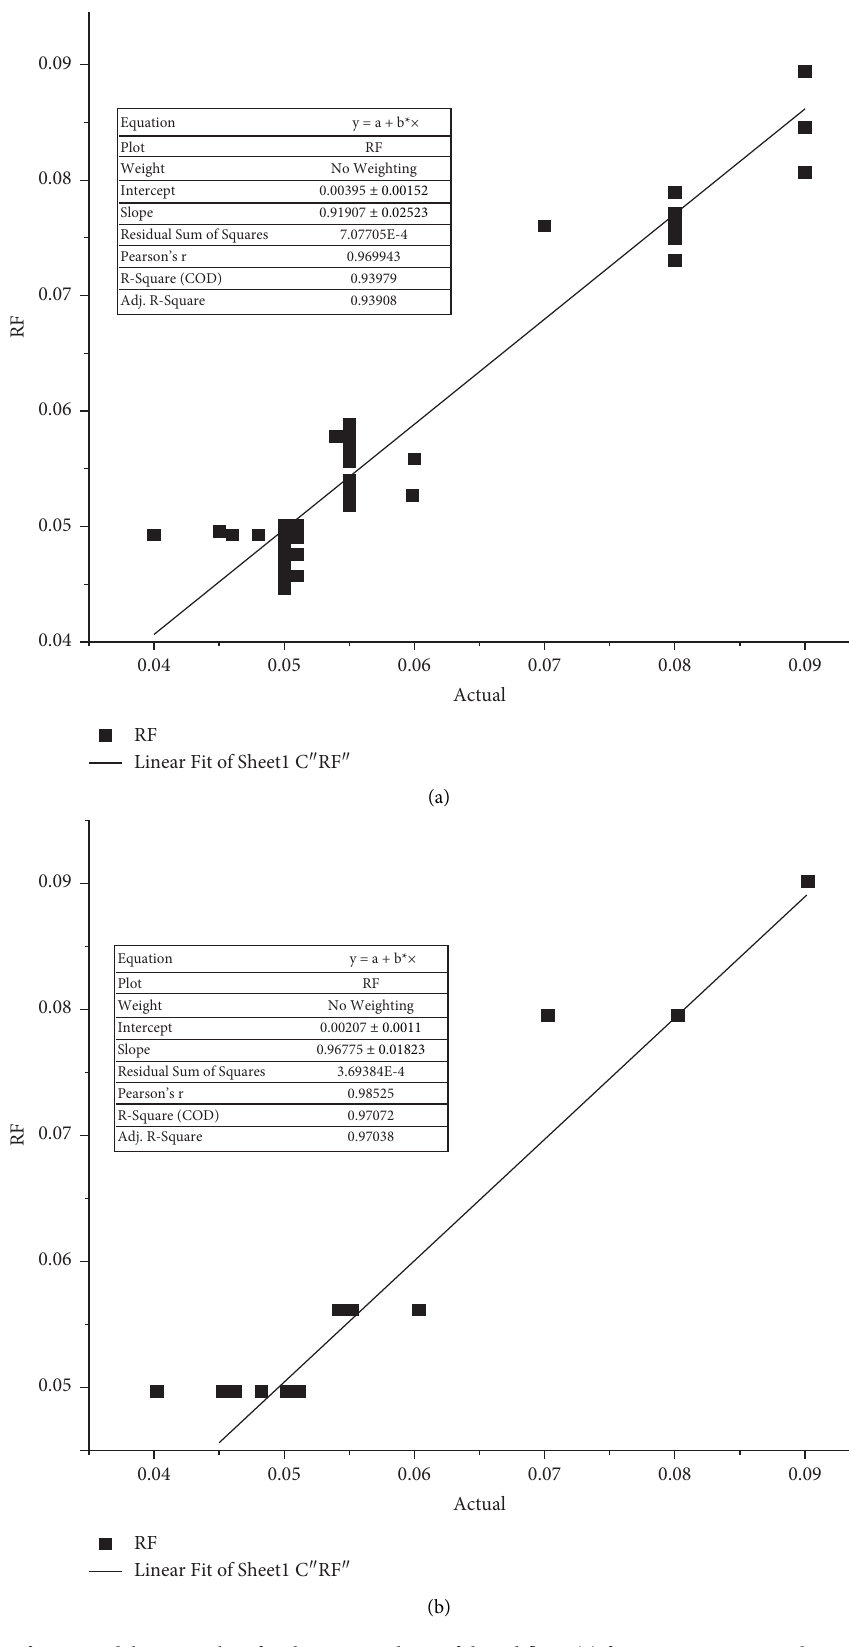
Figure 6: Te random forest model scatter plots for the testing phase of the oil fow: (a) fracture porosity in oil system and (b) shape